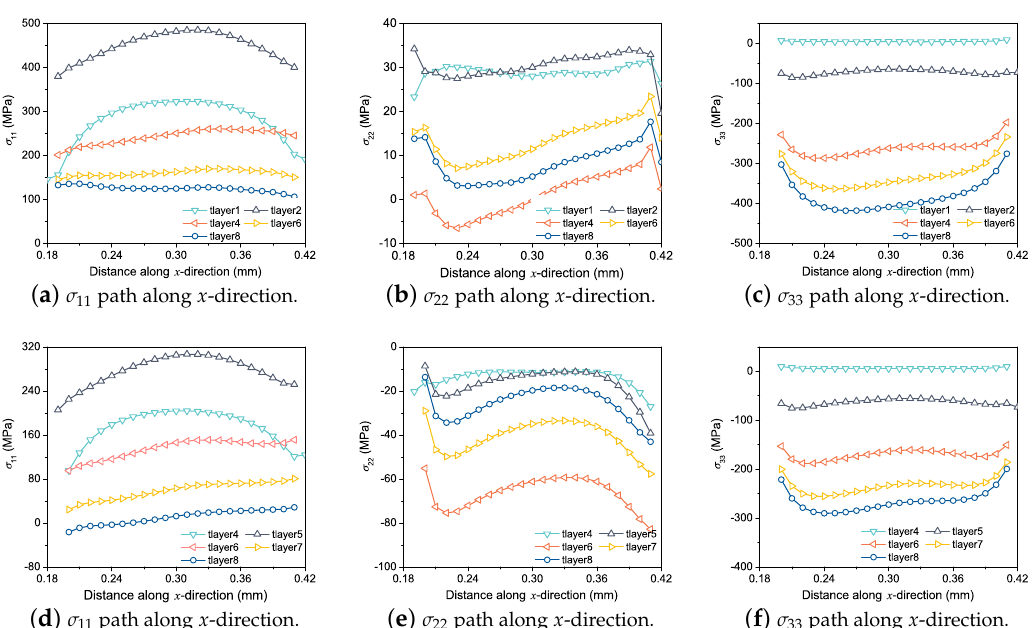
Figure 11. Residual stress distributions of ( a – c ) the 1st layer and ( d – f ) the 4th layer at the end time of each layer.